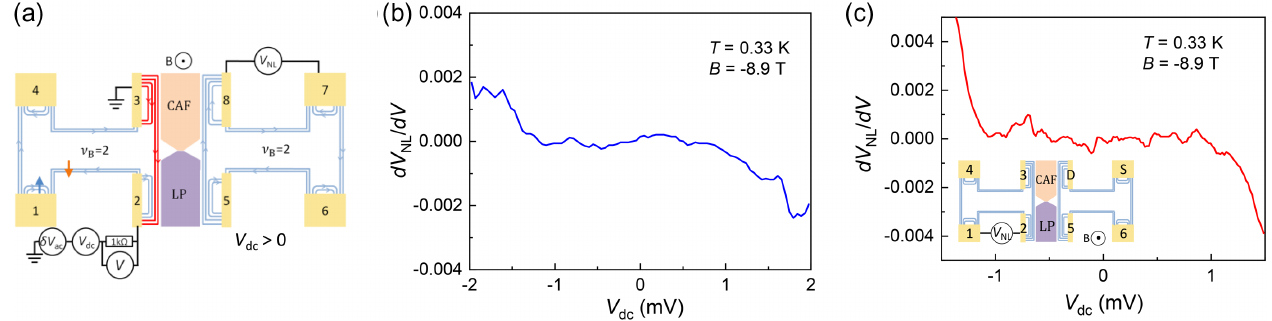
FIG. 10. (a) The same measurement setup as in Fig. 2(b) but with the B field pointing in the opposite direction. All edge states near the CAF phase departure from contact 3 and have the same chemical potential. Electron scattering cannot happen. (b) The measured both contacts 1 and 2 are away from the CAF region.